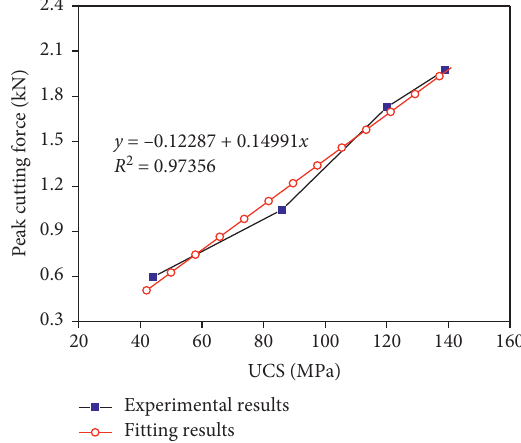
Figure 14: The relationship between PCF and